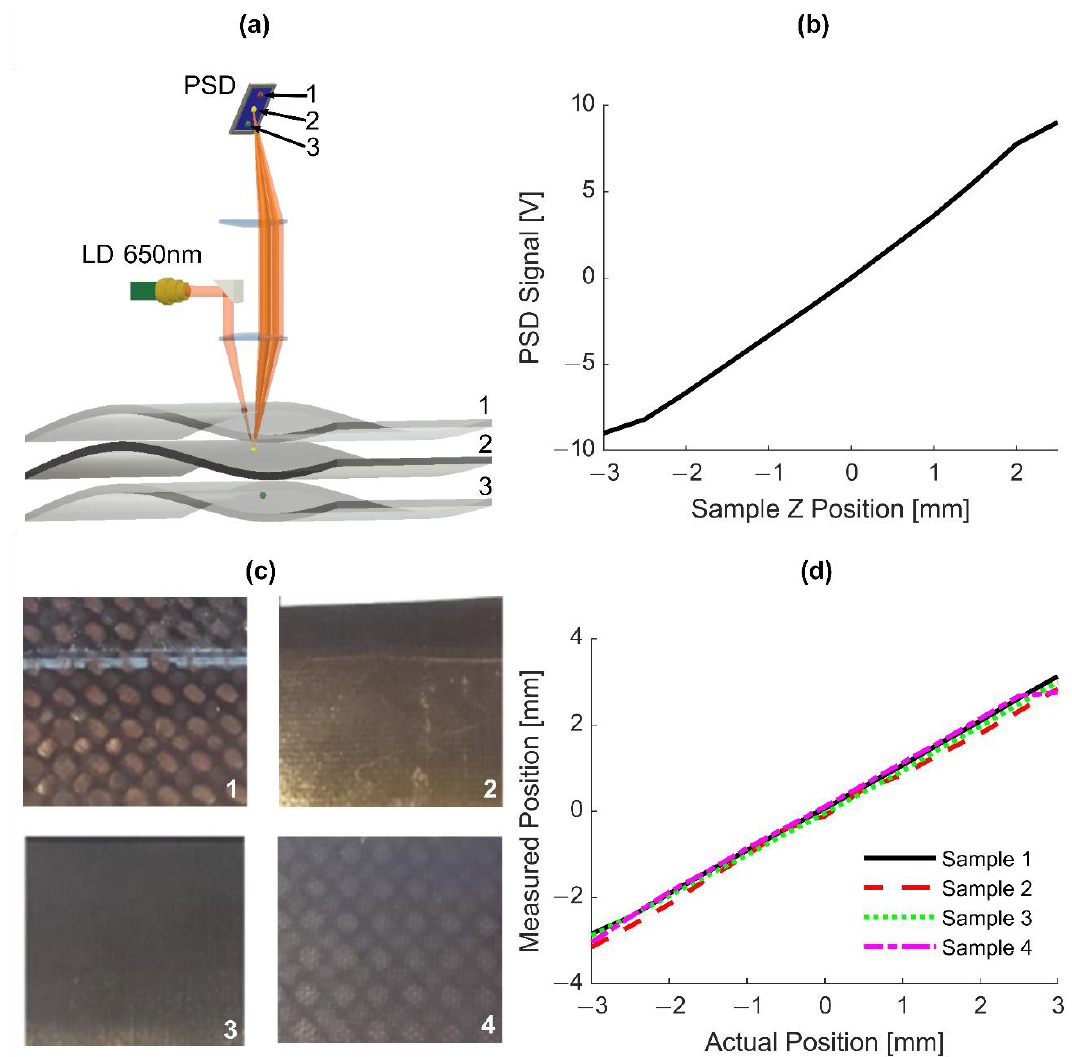
Figure 2. DACS operating principle for distance correction. ( a ) Sample surface position measurement concept shows how different surface levels map to different locations on a position-sensitive detector (PSD). ( b ) PSD signal output dependence on surface Z position. ( c ) Composite samples used for DACS testing. ( d ) Linearity of the measured surface position compared to the actual surface position for each sample.